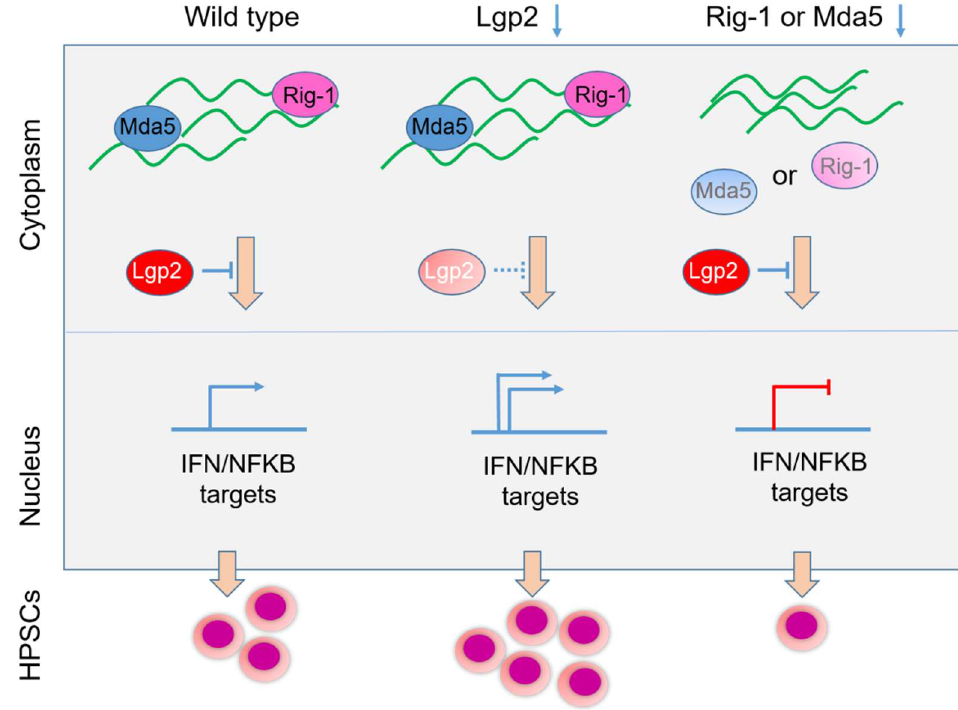
Figure 3. Proposed mechanism for repeat element RNA-dependent activation of the innate immune receptors Rig-1 and Mda5 and negative control by Lgp2 in hematopoietic stem and progenitor cells. Inflammatory signaling is a key regulator of developmental hematopoiesis, but the mechanisms driving such signals have remained unknown. Recent studies in mouse and zebrafish systems have provided insight into the underlying mechanisms by revealing endogenous repetitive element RNAs as activators of the pathogen pattern recognition receptors (PRR) of the RIG-I-like receptor family during embryonic hematopoiesis. RIG-I-like receptor activation induces inflammatory signals necessary for hematopoietic stem and progenitor cell generation ( left panel). Lgp2 deficiency (LGP2 encoded by the DHX58 gene in humans) enhances inflammatory signaling via IFN/NFκB and HSPC formation ( center panel). Rig-I or Mda5 deficiency impairs inflammatory signaling and HSPC formation ( right panel). Overexpression of repeat element RNA (specifically a SINE RNA that is schematically represented in green) enhances HSPC formation by engaging Rig-I and Mda5 (adapted from [9] and described in detail below).